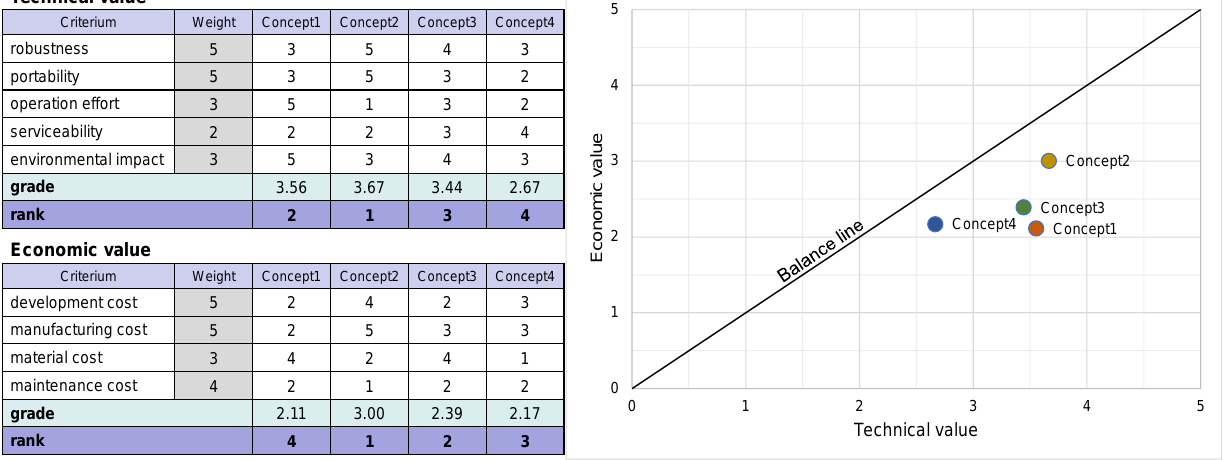
Figure 3. Example of concept evaluation ( left ), and graphical representation of technical and eco- nomic value balance of the synthesized concepts ( right )